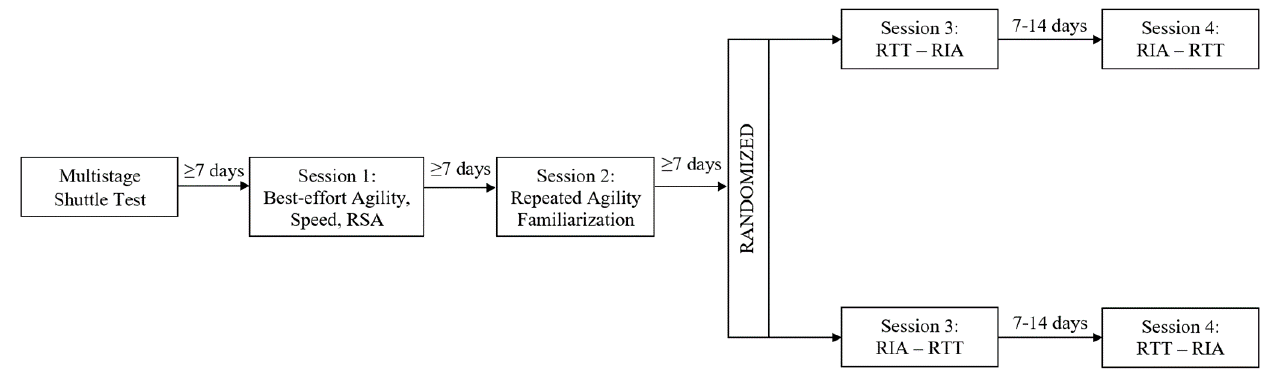
Figure 1. Schematic of the research design consisting of four sessions, including best-effort agility, speed, repeat sprint ability (RSA), repeated T-test agility (RTT) and repeated Illinois agility (RIA)